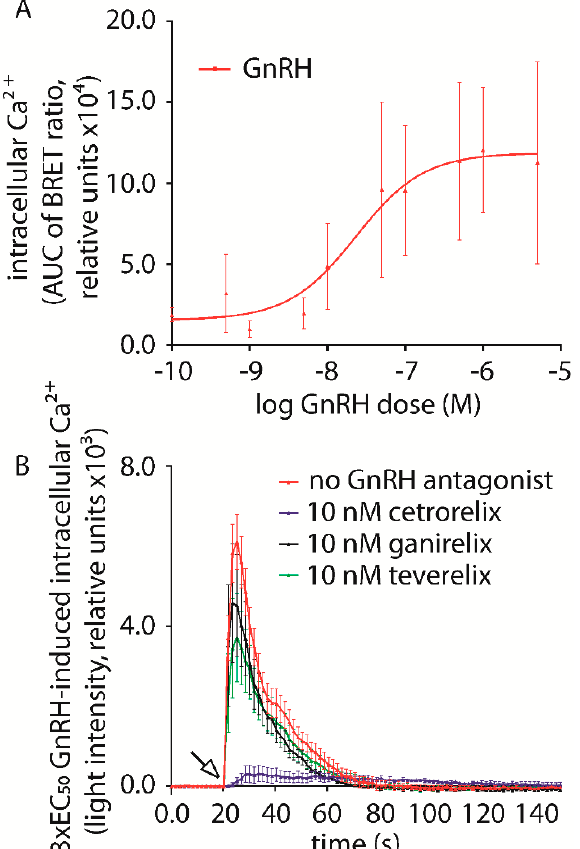
Figure 2. Analysis of the kinetics of GnRH-induced intracellular Ca 2+ increase, in HEK293/GnRHR cells, in the presence or in the absence of GnRH and antagonists. ( A ) Ca 2+ BRET biosensor signal was measured over 150 s and the arrow indicates the GnRH injection (pM–µM range) that occurred at the 20 s time-point. AUCs were calculated from kinetic data and represented as means ± SEM. The dose-response curve was obtained by interpolating means of AUC data using non-linear regression (EC 50 = 23.26 ± 3.37 nM; means ± SEM; n = 3). ( B ) Kinetics of 3 × EC 50 GnRH-induced intracellular Ca 2+ increase, in the presence or in the absence of 10 nM Cetrorelix, Ganirelix and Teverelix. Light emissions are represented in the X-Y graph as means ± SEM and consecutive points were connected by lines. AUC of antagonists were calculated and statistically compared (Cetrorelix AUC = 21,482 ± 6718; Ganirelix AUC = 73,164 ± 16,237 *; Teverelix AUC = 74,321 ± 17,569 *; 3 × EC 50 GnRH AUC = 109,340 ± 13,866 *; * = significantly different versus Cetrorelix AUC; Kruskal-Wallis test; p < 0.005; means ± SEM; n = 6).